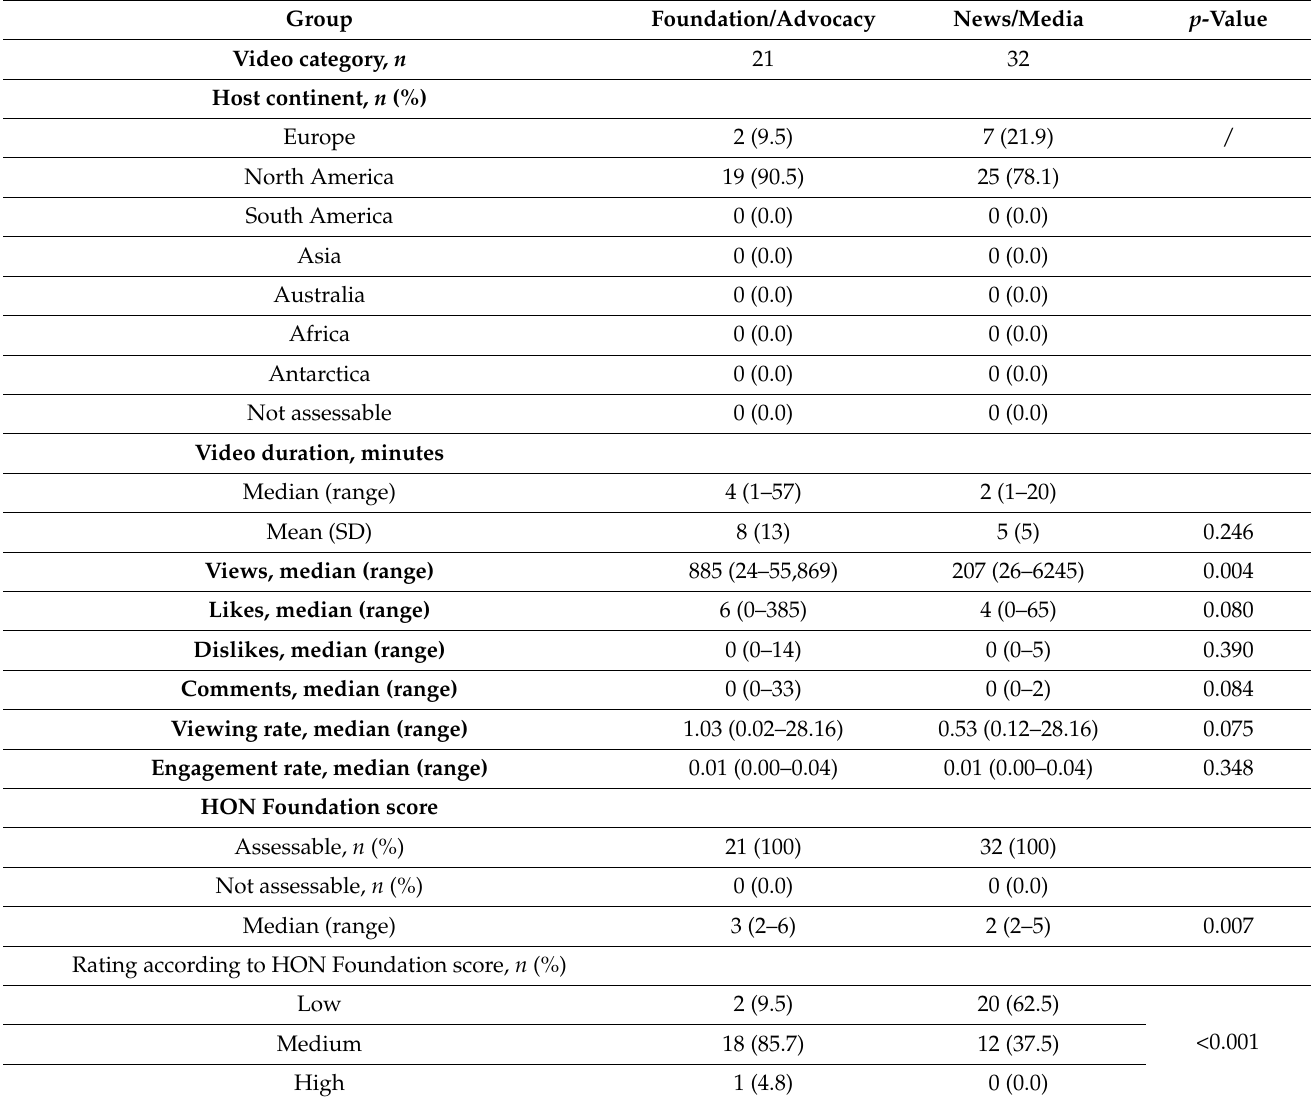
Table 5. Characterization of videos by